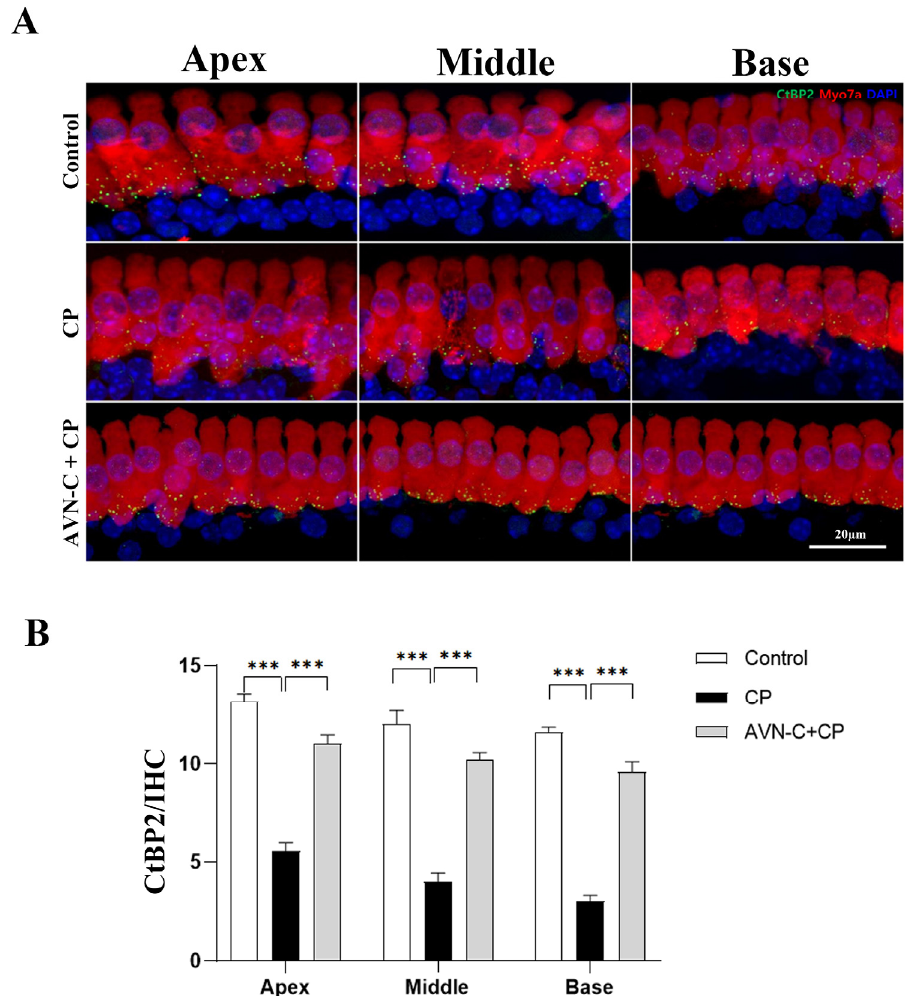
Figure 3. A comparison of presynaptic ribbons based on different treatment plans. ( A ) Representative images of C-terminal binding protein 2 (CtBP2) stained in the IHC. ( B ) Compared to the control and AVN-C-treated groups, the CtBP2 signal is reduced in the CP group, and this indicates the death of presynaptic ribbons (one-way ANOVA, *** p ≤ 0.001, at apex, middle, and base turns, Control vs. CP; AVN-C vs. CP). The IHCs were stained with Myosin7a. (n = 5 each group). One-way ANOVA was used, with p ≤ 0.05 indicating significance.